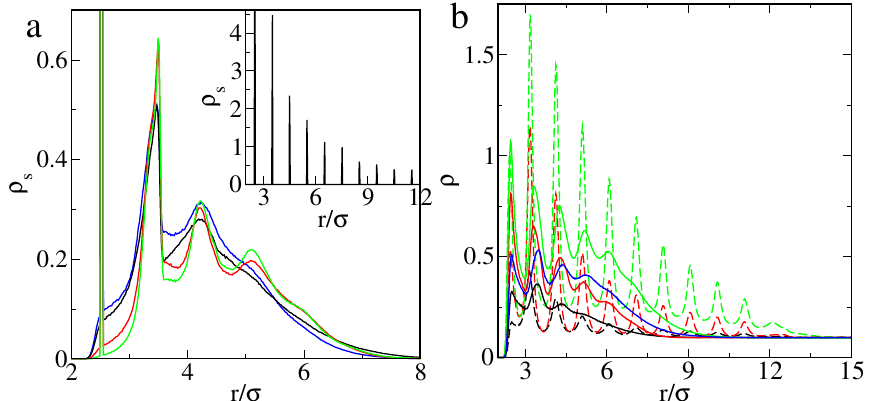
Figure 8. Density profiles of the chain segments ( a ) and fluid particles ( b ) around the core at ρ 0 = 0.1 for particles with attached flexible (solid lines) and rigid ligands (dashed lines) plotted for different models and values of ε Ps : models M1 and M2 with 1.5 ε (black lines), models M1 and M2 with ε Ps = 3.0 ε (red lines), models M1a and M2a with ε Ps = 3.0 ε (green lines), and model M1a with ε Ps = 1.5 ε (blue line). Other parameters: σ c = 4 σ , f = 20, M = 10. In the inset of part a, the segment density profile for the hedgehog-like particle is shown.